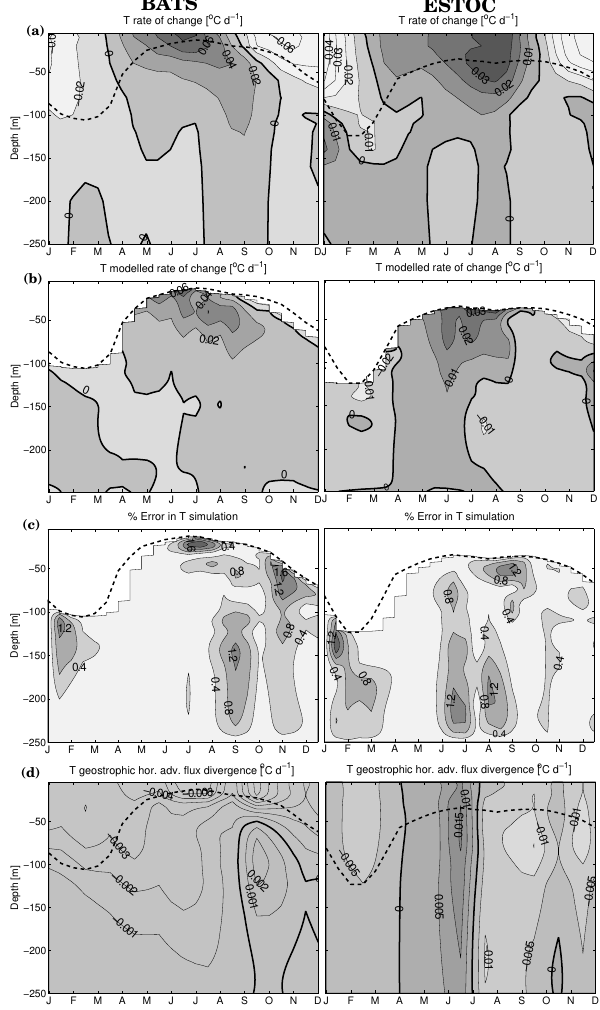
Fig. 5. (a) Observed and (b) simulated temperature rate of change, (c) errors in the simulated temperature seasonal cycle, and (d) geostrophic horizontal advection flux divergence at BATS and ES- TOC. The black discontinuous line represents the mixed layer depth and the black thick line represents the zero rate of change